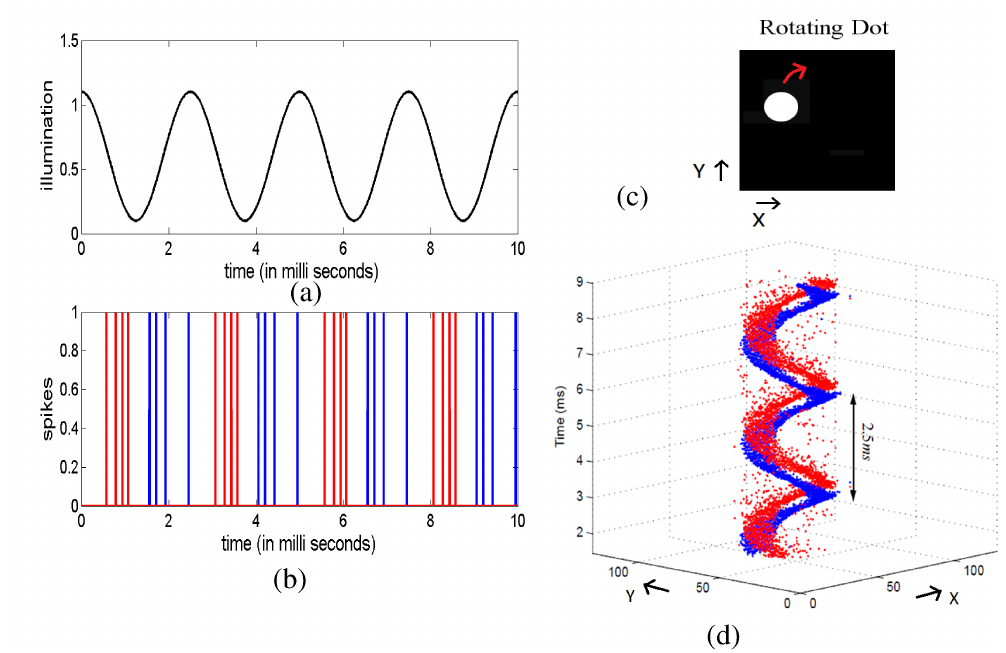
Figure 6. Illustration of the operation of a Dynamic Vision Sensor. ( a , b ) illustrate the operation a DVS pixel. ( a ) plots the illumination inpinging on a pixel that varies as a sinusoidal waveform along time with period 2.5 ms, and ( b ) illustrates the output spikes generated by the corresponding DVS pixel. The blue traces correspond to positive output spikes which are generated when the illumination increases, while the red traces illustrate the negative signed spikes generated by an illumination decreasing over time. ( d ) illustrates real measurements of the response of a DVS when observing a white rotating dot on a black background rotating with a 2.5 ms period, as shown in ( c